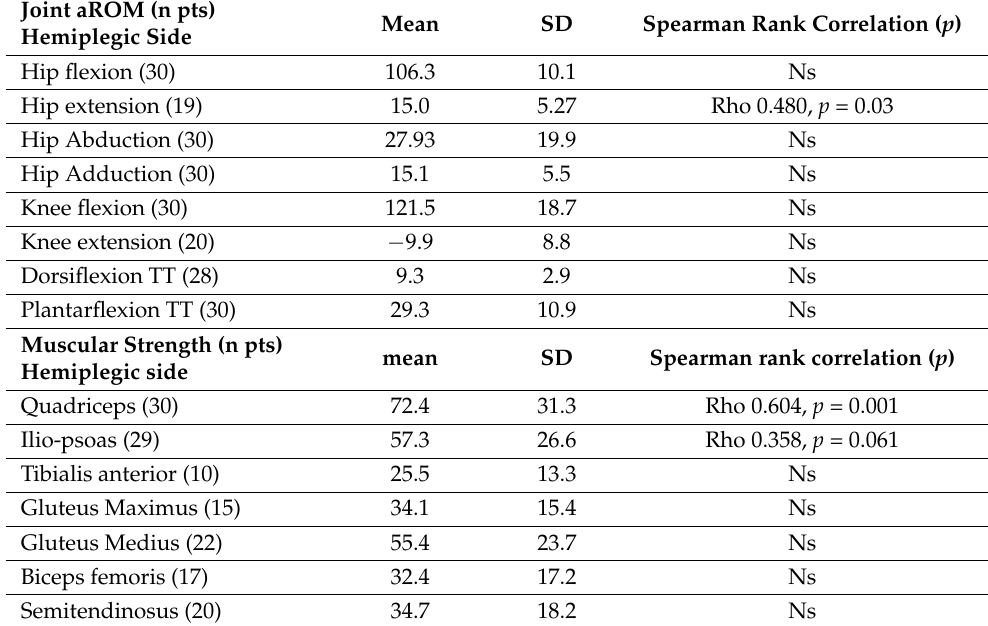
Table 3. Correlation with gait